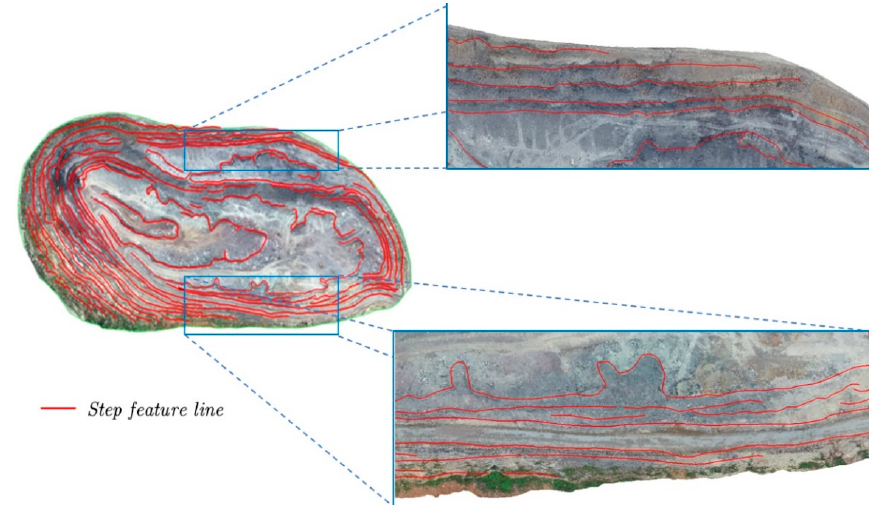
Figure 17. Step-feature lines (the general overhead view has been bolded for clarity).